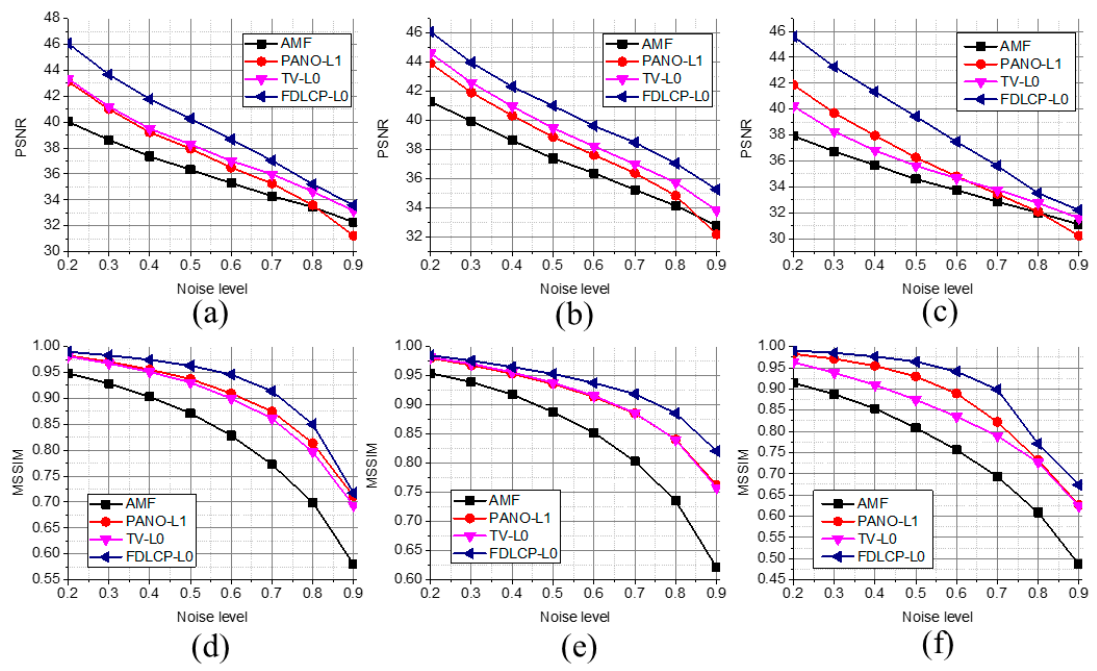
Figure 6. Quantitative measure at different noise levels. ( a )–( c ) are PSNRs of Boat , Lena , and Barbara images, respectively; ( d )–( f ) are MSSIMs of Boat , Lena , and Barbara images, respectively.